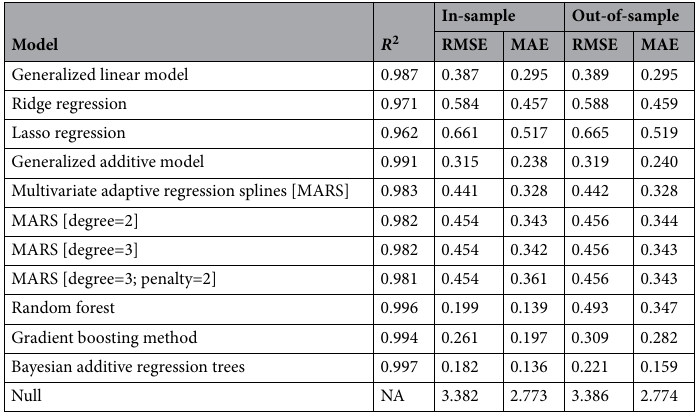
Table 1. Model performance